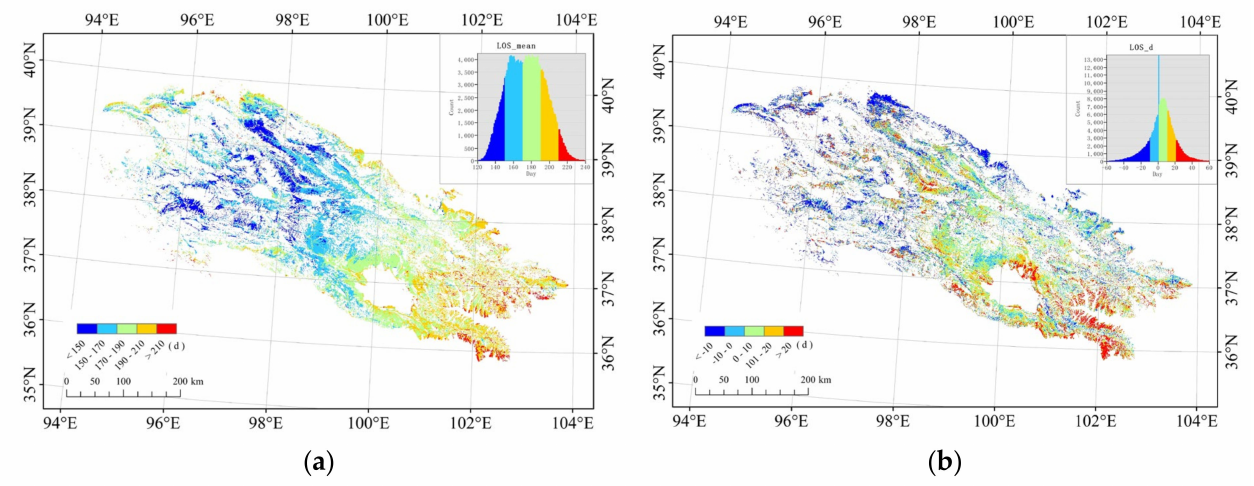
Figure 9. Spatial distribution of ( a ) average EOS for 20 years from 2000 to 2019 and ( b ) difference in EOS for 20 years by linear regression from 2000 to 2019.